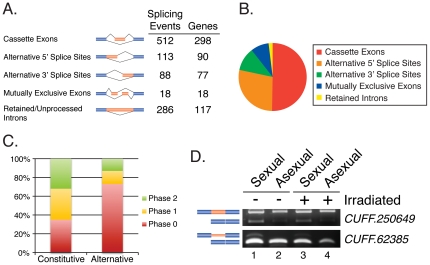
Classification of alternative splicing events.(A) Number of splicing events and genes detected for 5 classes of alternative splicing events: cassette exons, alternative 5′ splice sites, alternative 3′ splice sites, mutually exclusive exons and retained introns. (B) Percentage of each class of alternative splicing event shown in piechart. (C) Frame preservation in constitutively and alternatively spliced cassette exons; phase 2 and phase 1 exons are out-of-frame; phase 0 exons are in-frame. (D) RT-PCR validation of strain-specific alternative splicing events in non-irradiated (−) and irradiated (+) sexual and asexual animals. A cassette exon (CUFF.250649) is shown in top gel, while a retained intron (CUFF.62385) is shown in the bottom gel.